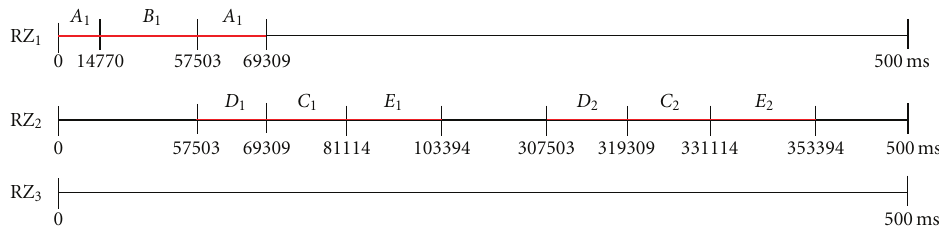
Figure 10: Mapping/scheduling